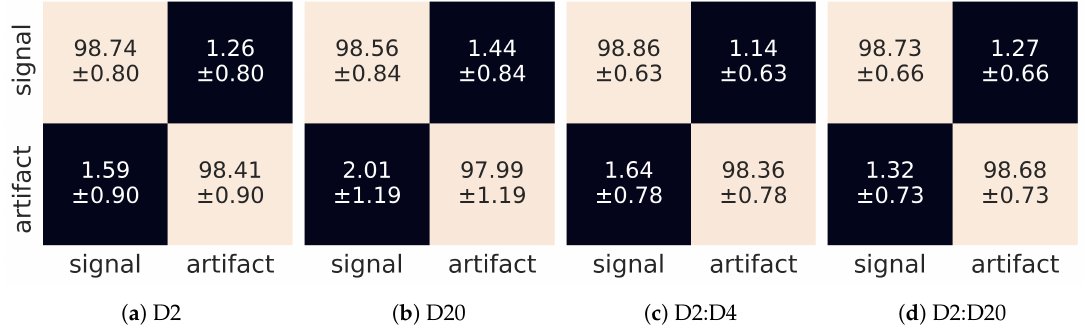
Figure 11. Confusion matrices for different input tensors: ( a ) single D2 wavelet, ( b ) single D20 wavelet, ( c ) composition of [D2,D4] wavelets, ( d ) composition of [D2,D4,D6,...,D20] wavelets. The horizontal and vertical dimensions refer to predicted and judged labels, respectively.